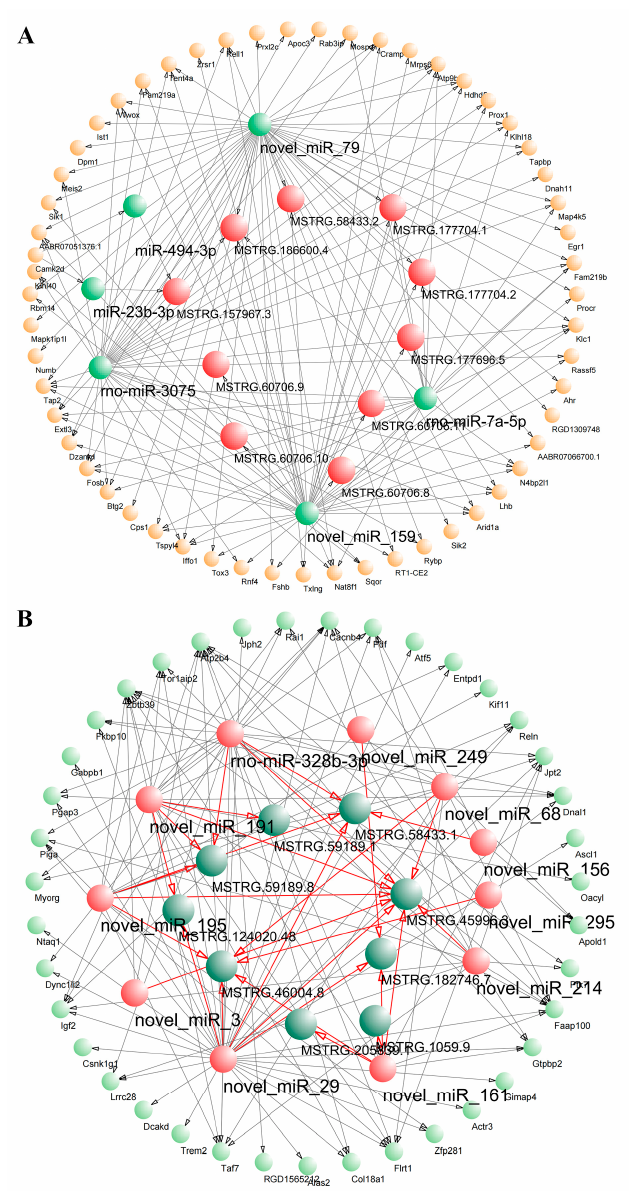
Figure 5. Interactions among lncRNAs, mRNAs, and miRNAs. ( A ) GnRH-promoting ceRNA regulatory network in the rat adenohypophysis. ( B ) GnRH-inhibitory ceRNA regulatory network in the rat adenohypophysis.